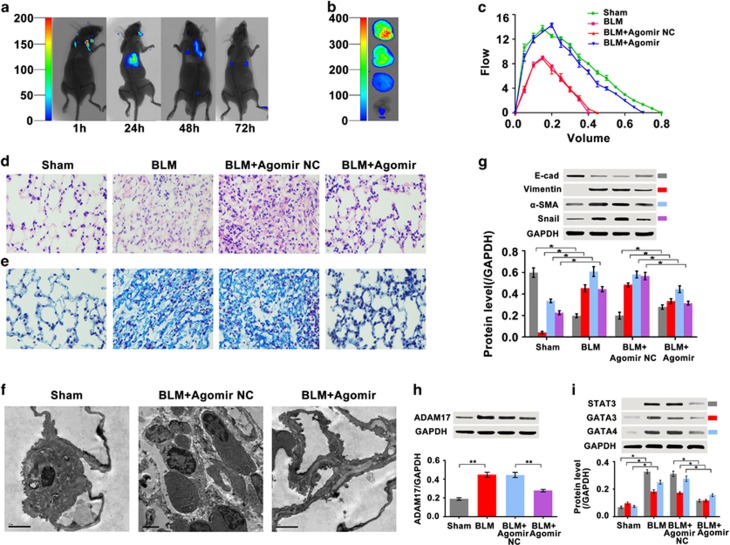
Anti-pulmonary fibrosis activity of miR-708-3p
in vivo. (a) The miR-708-3p agomir, fluorescently labeled with Cy5, was tracked and observed to concentrate in the lung, as revealed by small-animal imaging technology. (b) The animal lungs were imaged at each time point through small-animal imaging technology. (c) The FVC% in the miR-708-3p agomir and sham groups was higher than those in the BLM group. (d) H&E staining revealed thinner alveolar walls of tissue sections and more continuous structures in the miR-708-3p agomir-treated group than in the BLM group (× 400 magnification). (e) Masson’s trichrome staining showed that miR-708-3p agomir treatment reduced the number of fibroblasts and the amount of collagen matrix relative to those in the BLM group. Blue stain denotes collagen (× 400 magnification). (f) Ultrastructural changes were observed in the cells of the miR-708-3p agomir and sham groups, as observed by TEM. (g) MiR-708-3p agomir promoted E-cadherin expression and inhibited α-SMA, vimentin and Snail expression. (h) MiR-708-3p agomir blocked ADAM17 expression. (i) MiR-708-3p agomir diminished the STAT3, GATA3 and GATA4 expression levels. Each bar represents mean±s.d.; n=6. *P<0.05, **P<0.01. H&E, hematoxylin and eosin.